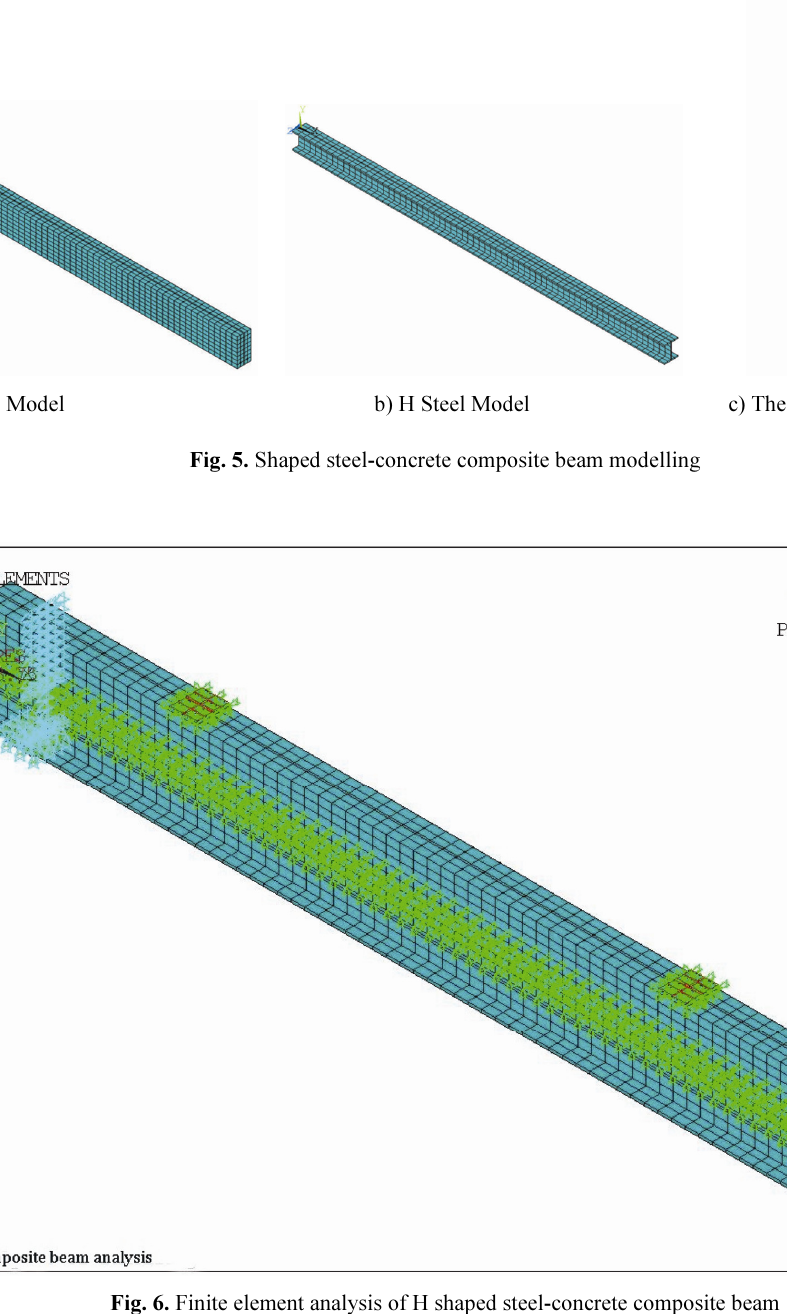
Fig. 6. Finite element analysis of H shaped steel-concrete composite